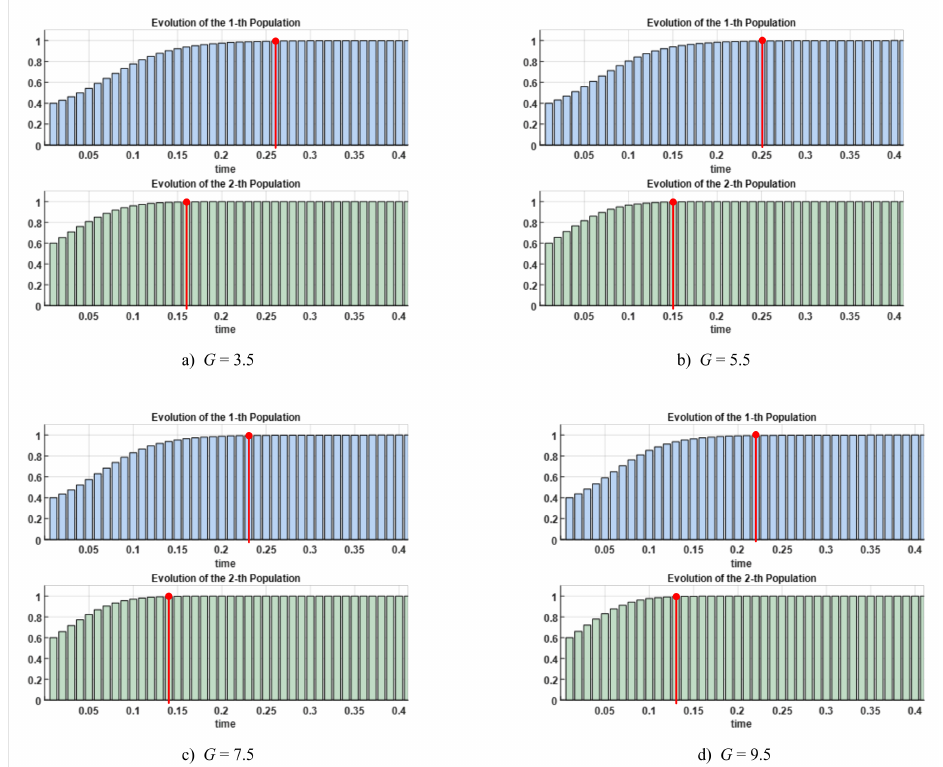
Figure 6. Influence of G change on system